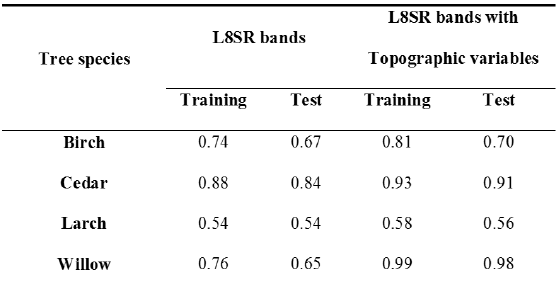
Table 1. Reported AUC values for training set and